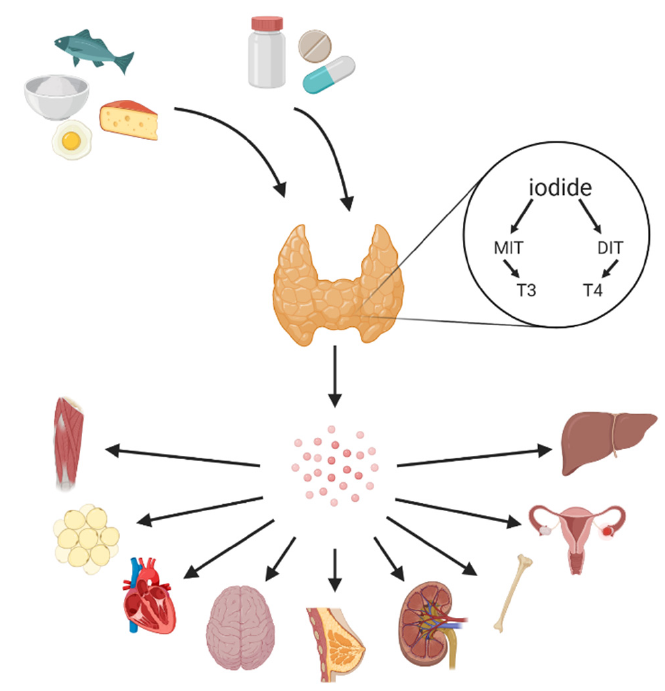
Figure 1. Iodine can be ingested through the diet and dietary supplements. The primary sources of iodine are salt, seafood, fish, algae, milk, and dairy. Iodine is taken up by the thyroid gland and used for synthesis MIT (monoiodotyrosine) and DIT (diiodotyrosine), which are used for thyroid hormone (triiodothyronine and thyroxine) biosynthesis. Receptors of thyroid hormones are on the surface of different organs; thus, thyroid hormones travel in the blood and may affect many systems among other reproductive system, skeletal or muscular system.